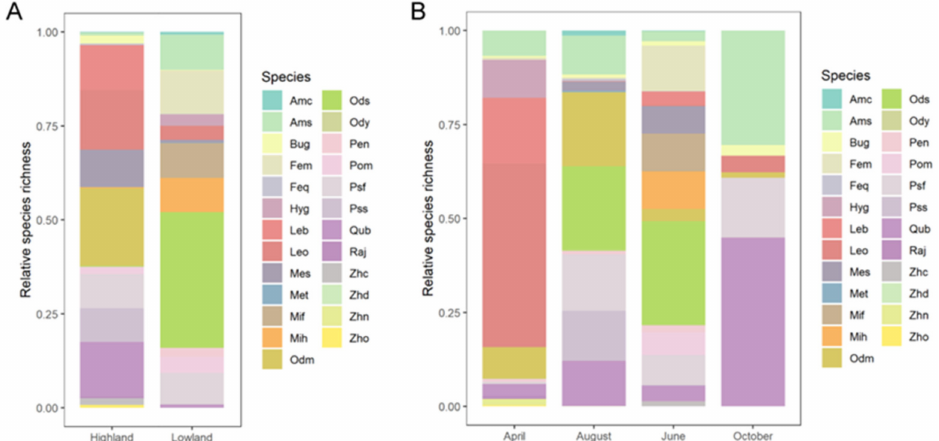
Figure 1. Elevational spatial and seasonal temporal compositions of amphibian species. ( A ) Am- phibian composition in highland and lowland sites. ( B ) Amphibian composition in four different months. Species abbreviations are as follows: Amc: Amolops chunganensis , Ams: Amolops sinensis